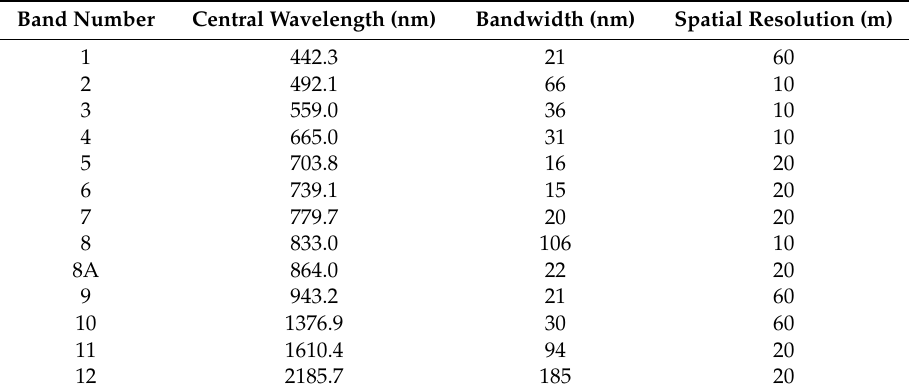
Table 1. Sentinel-2B Band’s Characteristics [34].